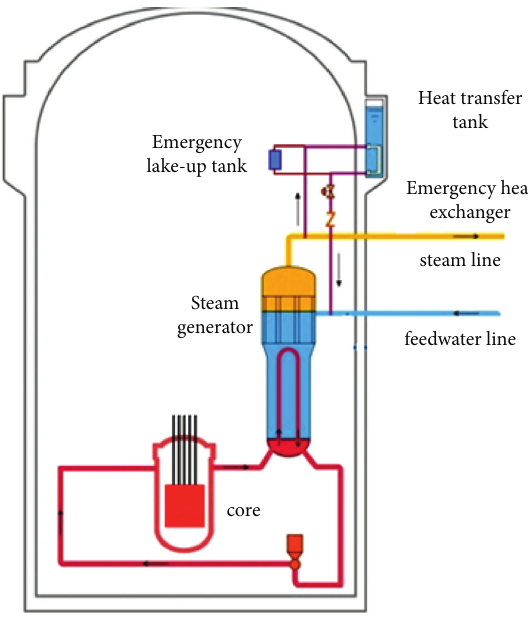
Figure 1: Schematic diagram of the